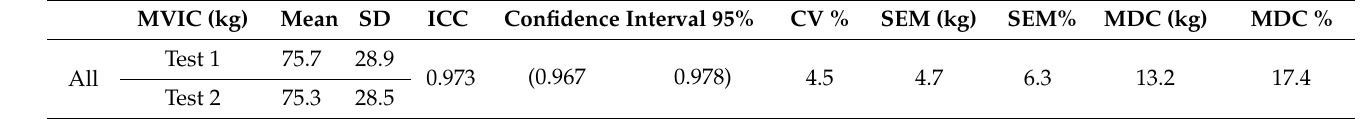
Table 3. Reliability of isometric